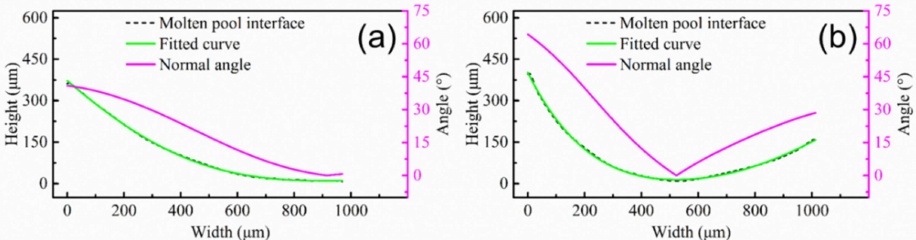
Figure 9. Molten pool interface and normal angle with different pulse period: ( a ) 30 ms; ( b ) 100